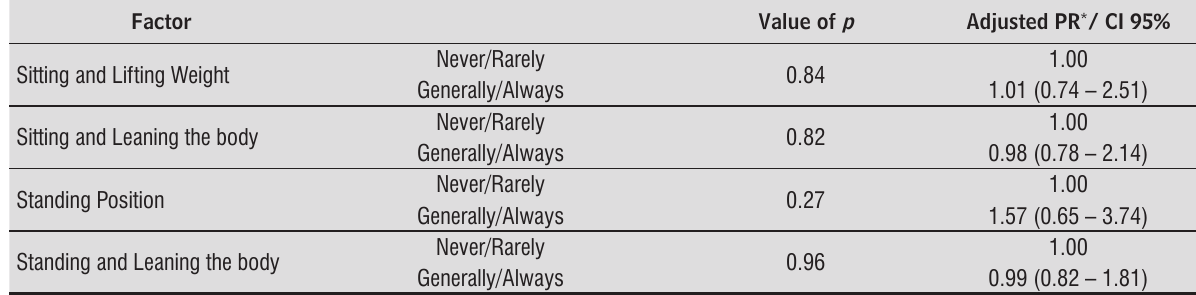
Table 5 - Poisson’s regression analysis for low back pain in elderly